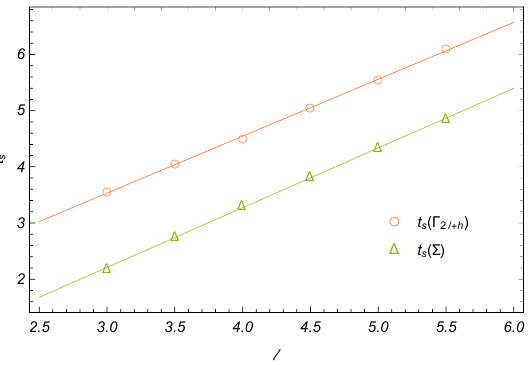
Figure 8 . Time evolution of r d ; r w and r u . Clearly, r w always obeys the bound r d Left : for h = 0 : 46 and ‘ = 1 : 5 the connected con(cid:12)guration is always favored for any boundary time. Right : for h = 1 and ‘ = 4 : 5 the disconnected con(cid:12)guration is favored at late times. Here the transition between connected and disconnected con(cid:12)gurations happens at t (cid:24) 3 : 82.